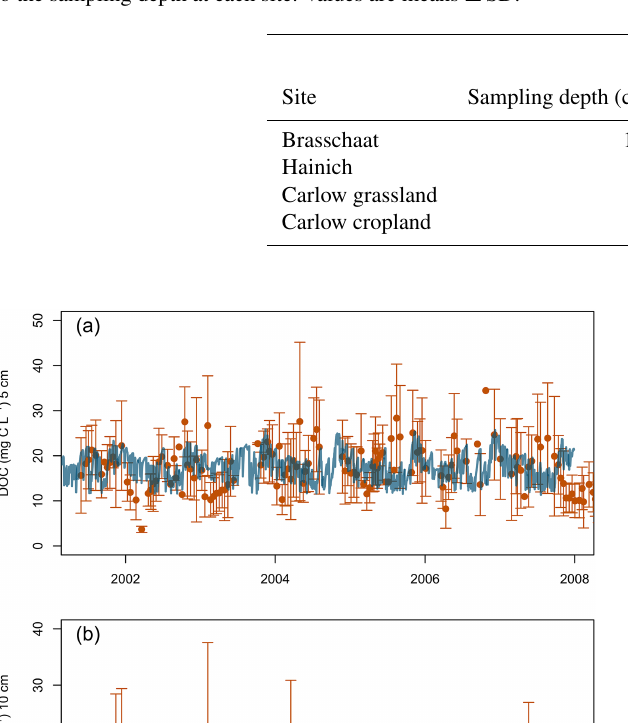
Table 3. Simulated and observed mean soil organic carbon (SOC) stocks in the selected sites. Simulated SOC stocks were calculated down to the sampling depth at each site. Values are means ± SD.